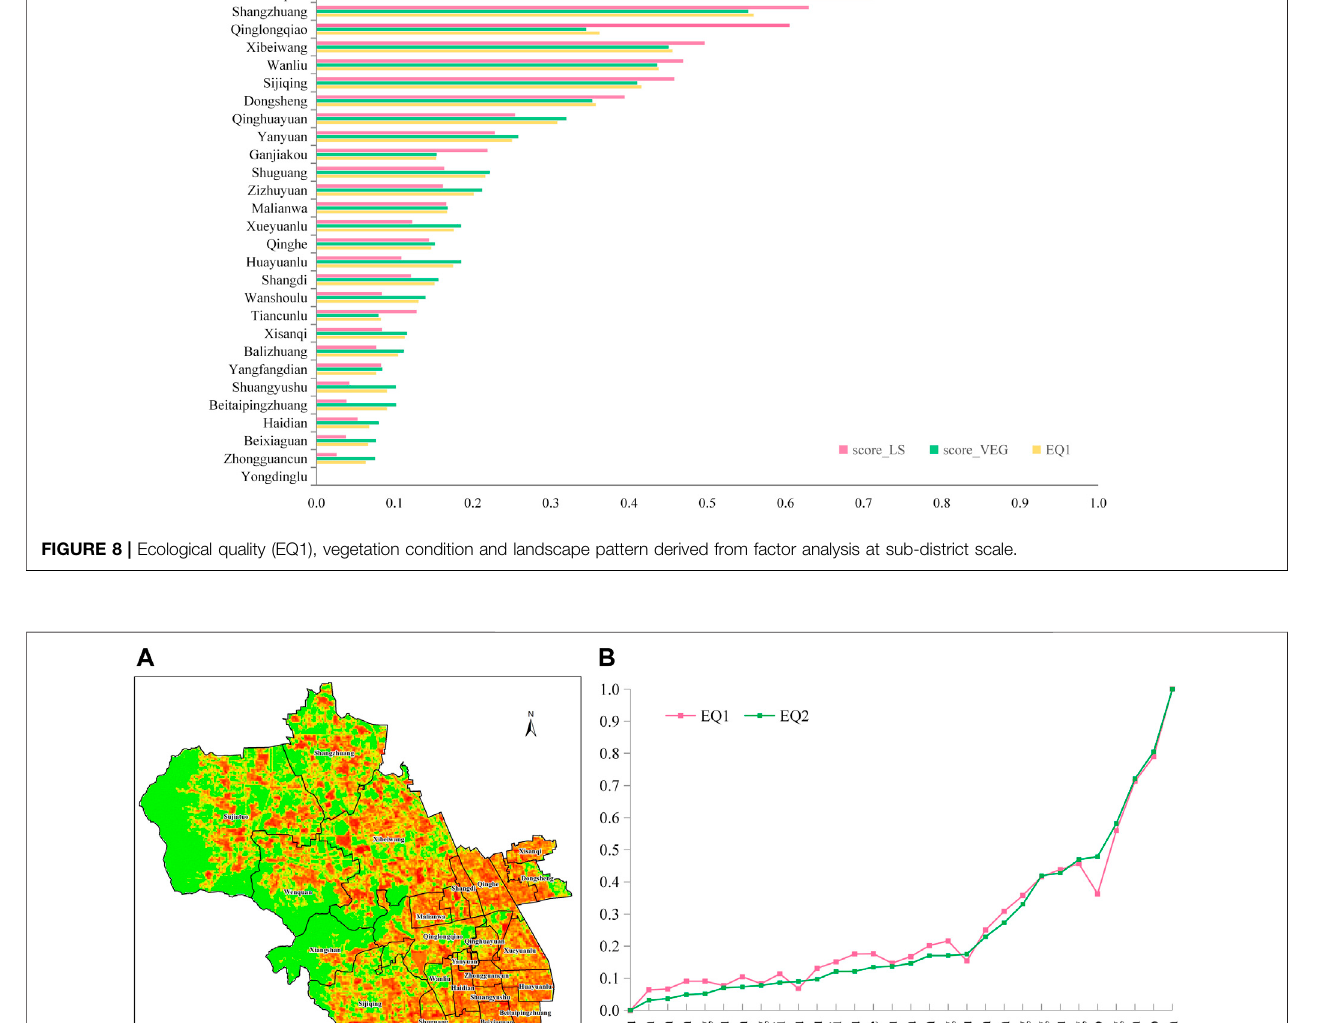
represent the levels of EQ2, vegetation condition and landscape pattern for each sub-district in Hiadian District.